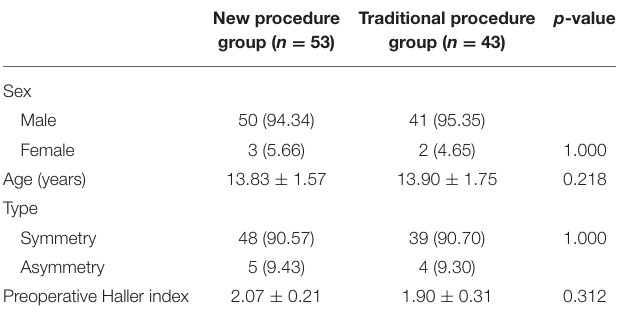
TABLE 1 | Comparison of patient information between new procedure and traditional procedure